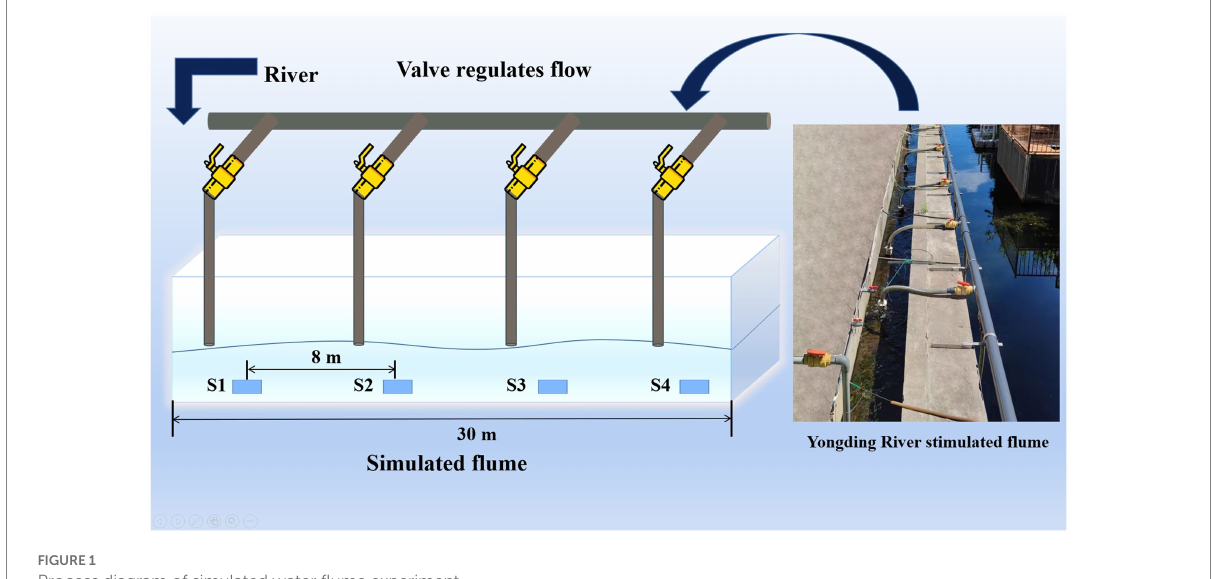
FIGURE 1 Process diagram of simulated water flume experiment.